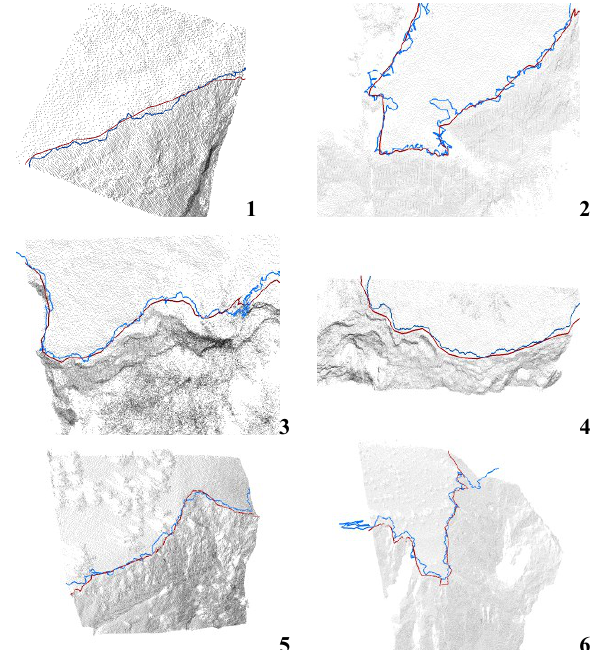
Figure.5. Shoulder lines with original point clouds. Red line is manual digitalization result, and blue line is automatic extraction result using our method.